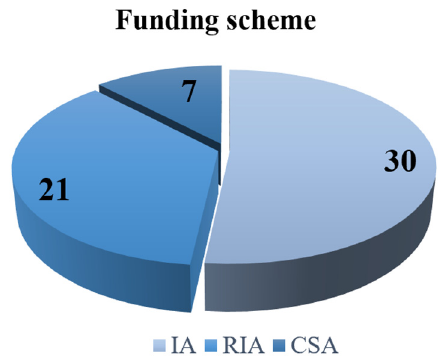
Figure 5. Number of projects per funding scheme: IA Innovation Action; RIA Research and Innovation Action; CSA Coordination and Support Action.